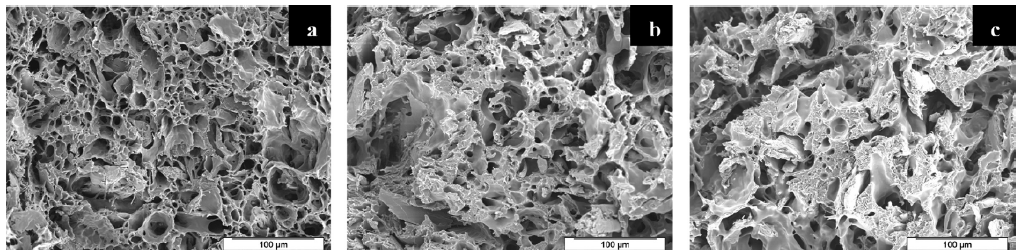
Figure 37. Effect of rheology modifier content on cell morphology of foamed PLA samples containing 20 wt% wood flour: ( a ) 2 wt%, ( b ) 4 wt%, and ( c ) 6 wt% E-43. Reprinted from Matuana and Díaz [155]. Copyright (2020) American Chemical Society.